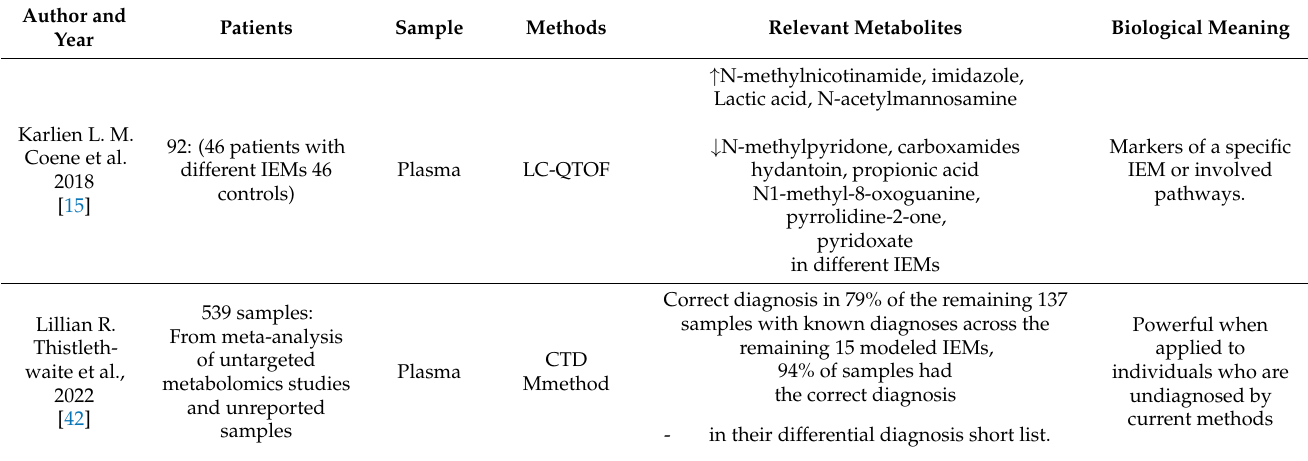
Table 5. Relevant Network applied methods studies applied to the IEMs